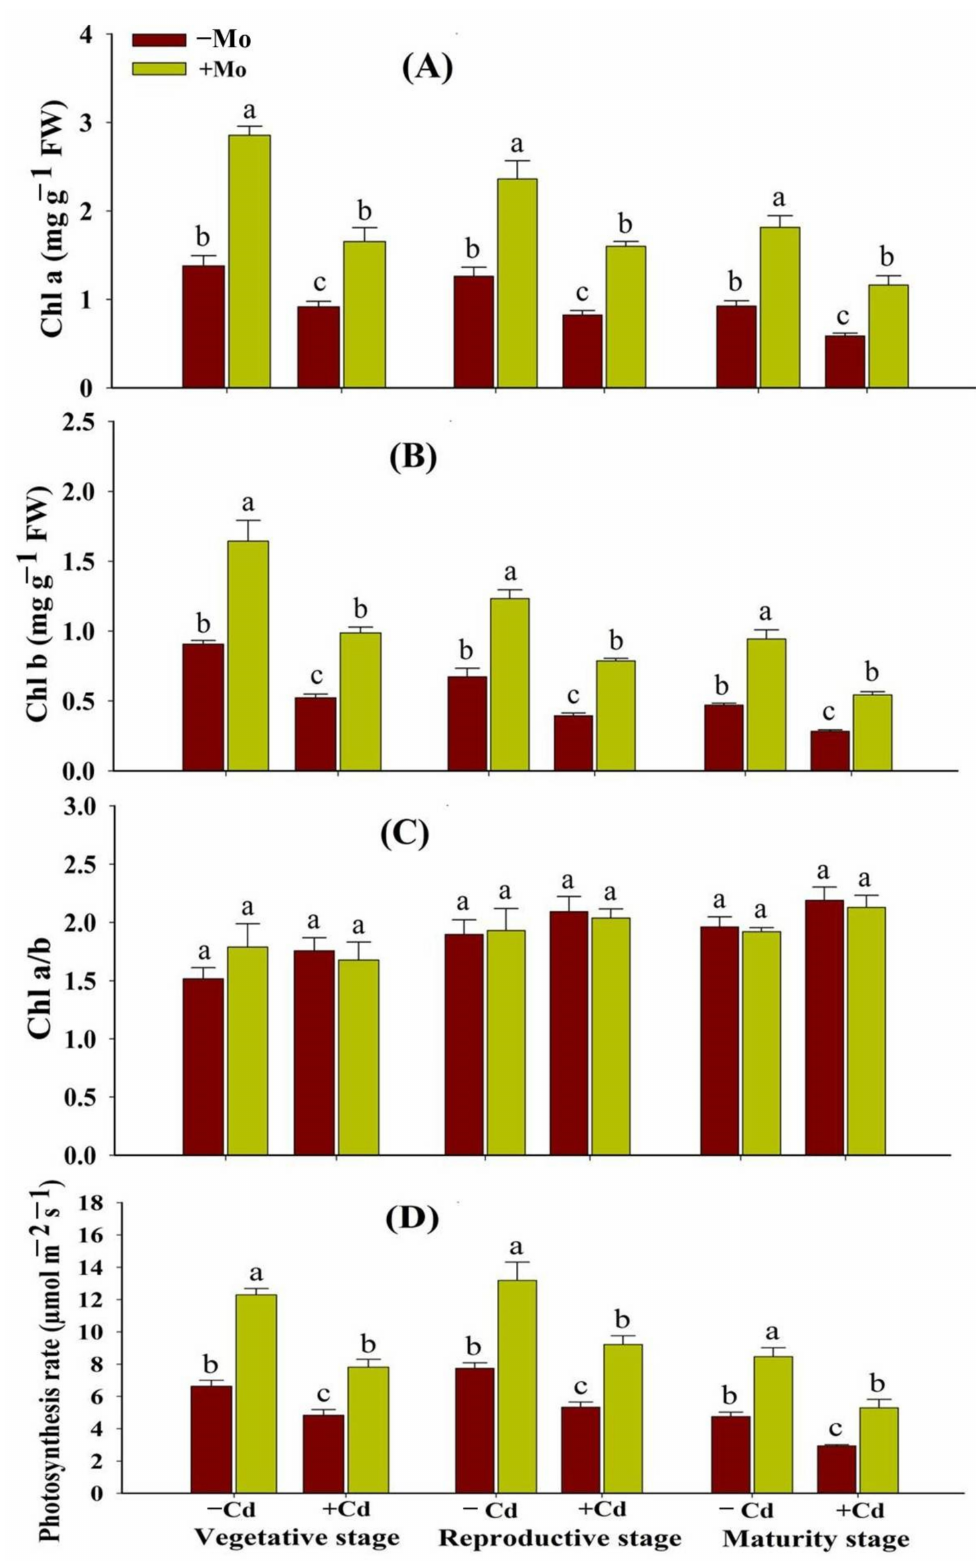
Figure 1. Effect of Mo supply and Cd toxicity on Chl a ( A ), Chl b ( B ), ratio of Chl a/b ( C ), and photosynthetic rate (P n ) ( D ), in leaves of aromatic rice ‘Xiangyaxiangzhan’ cultivar, at the vegetative, reproductive, and maturity stages. Bars above means indicate ± S.E. of four independent replicates ( n = 4) and different small alphabetical letters above means reveal significant differences among treatments within a particular growth stage according to the LSD test ( p <